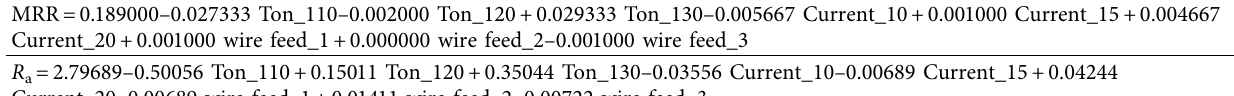
Table 6: Regression equation for MRR and R